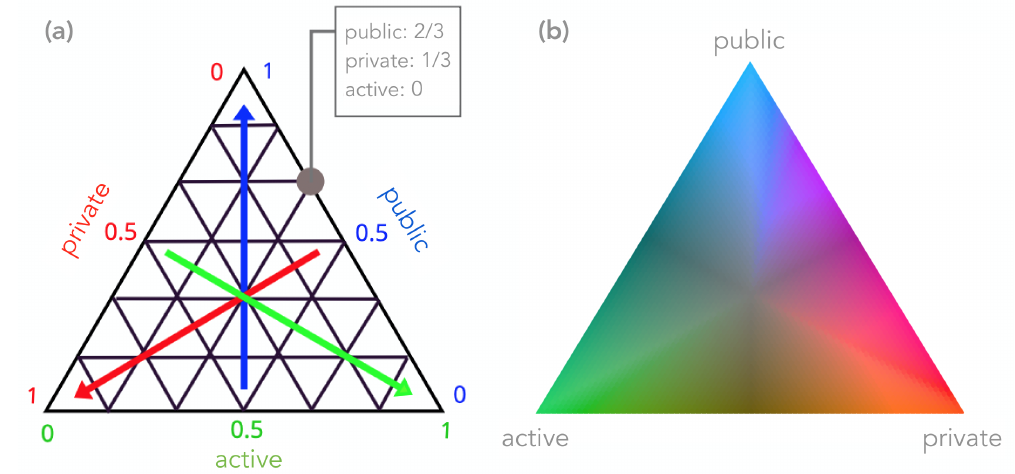
Figure 2. Ternary color scale construction schema ( a ) and resulting colormap ( b ) used to encode mode split across